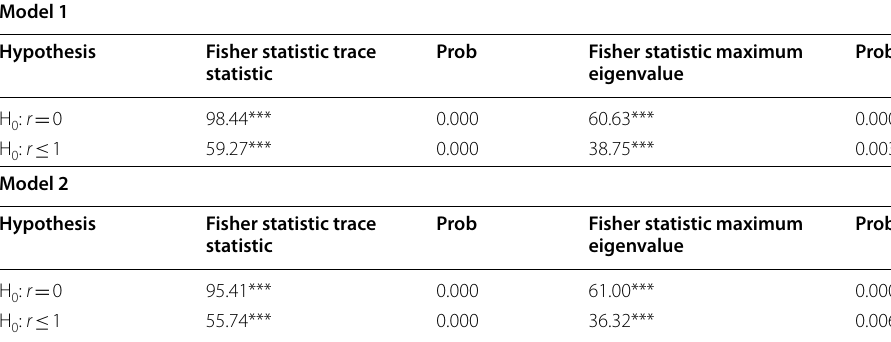
Table 4 Johansen–Fisher panel cointegration test